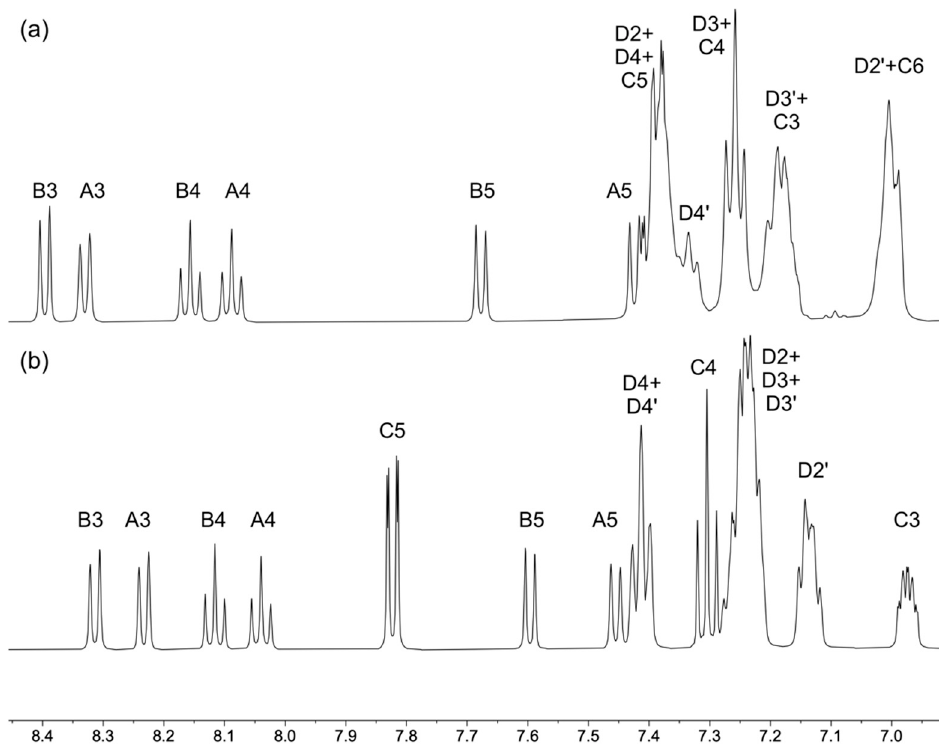
Figure 1. The aromatic regions of the 1 H NMR spectra of ( a ) [Cu(POP)(6-Cl-6’-Mebpy)][PF 6 ] and ( b ) [Cu(xantphos)(6-Cl-6’-Mebpy)][PF 6 ] (500 MHz, 298 K, acetone- d 6 ). The labeling scheme is shown in Scheme 1. Scale: δ /ppm.